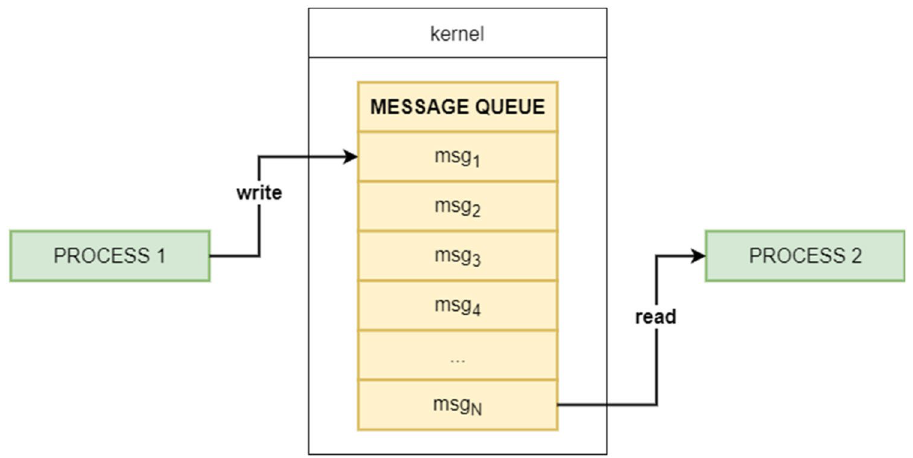
Fig. 3 Message queue